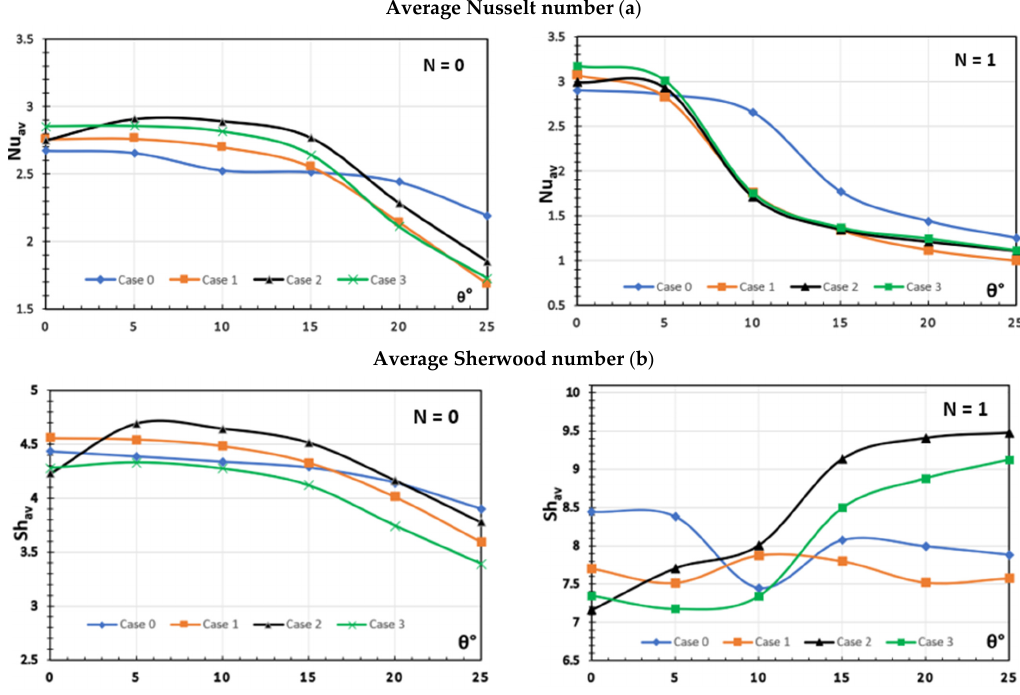
Figure 9. Effect of inclination on the average Nusselt ( a ) and Sherwood ( b ) in the all cases for Ra = 5 × 10 4 , N = 0 and N = 1. Ra = 5 × 10 4 , N = 0 and N =